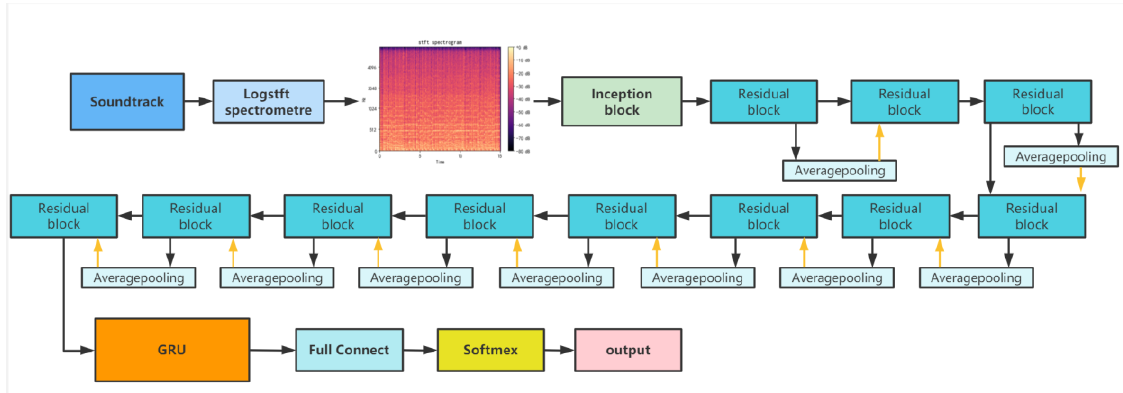
Figure 8. Block diagram of the proposed neural